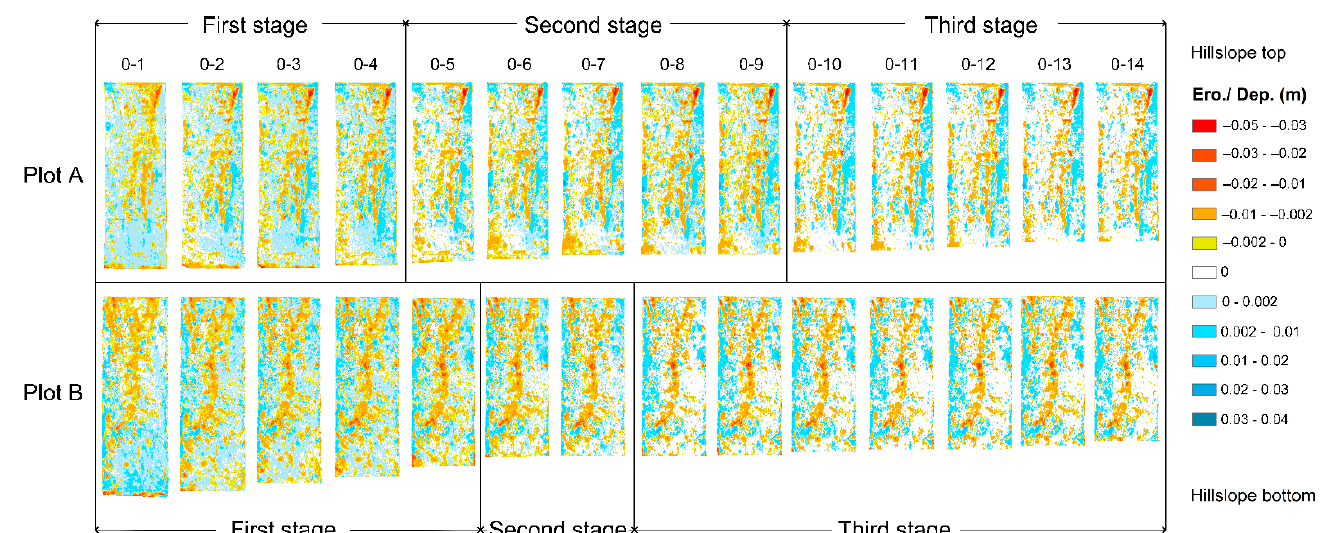
Figure 6. The spatial pattern of erosion–deposition derived based on the 5-mm grid-cell size for hillslopes of plots A and B after each of the 14 experiments. In the legend, “0” indicates that no significant elevation change was detected (i.e., no erosion or deposition).